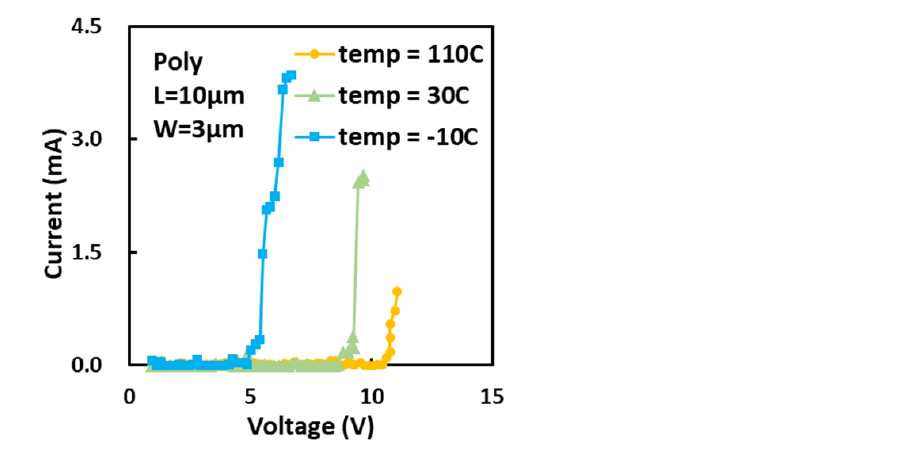
Figure 11. Temperature e ff ects of a sample poly-crystalline gNEMS ESD switch via TLP testing.